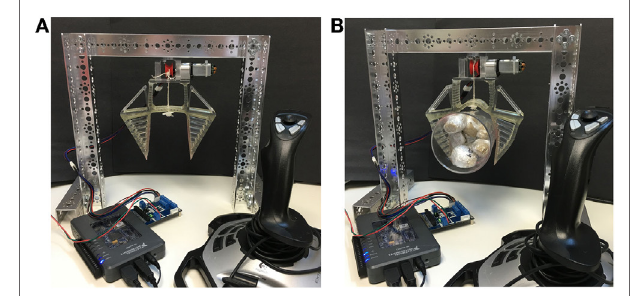
FigUre 4 | The arrangement Tihra finger placed next to a cylindrical object that was modeled in nastran . Hard material, represented by red, was modeled as ABS, and soft material, represented by blue, was modeled as